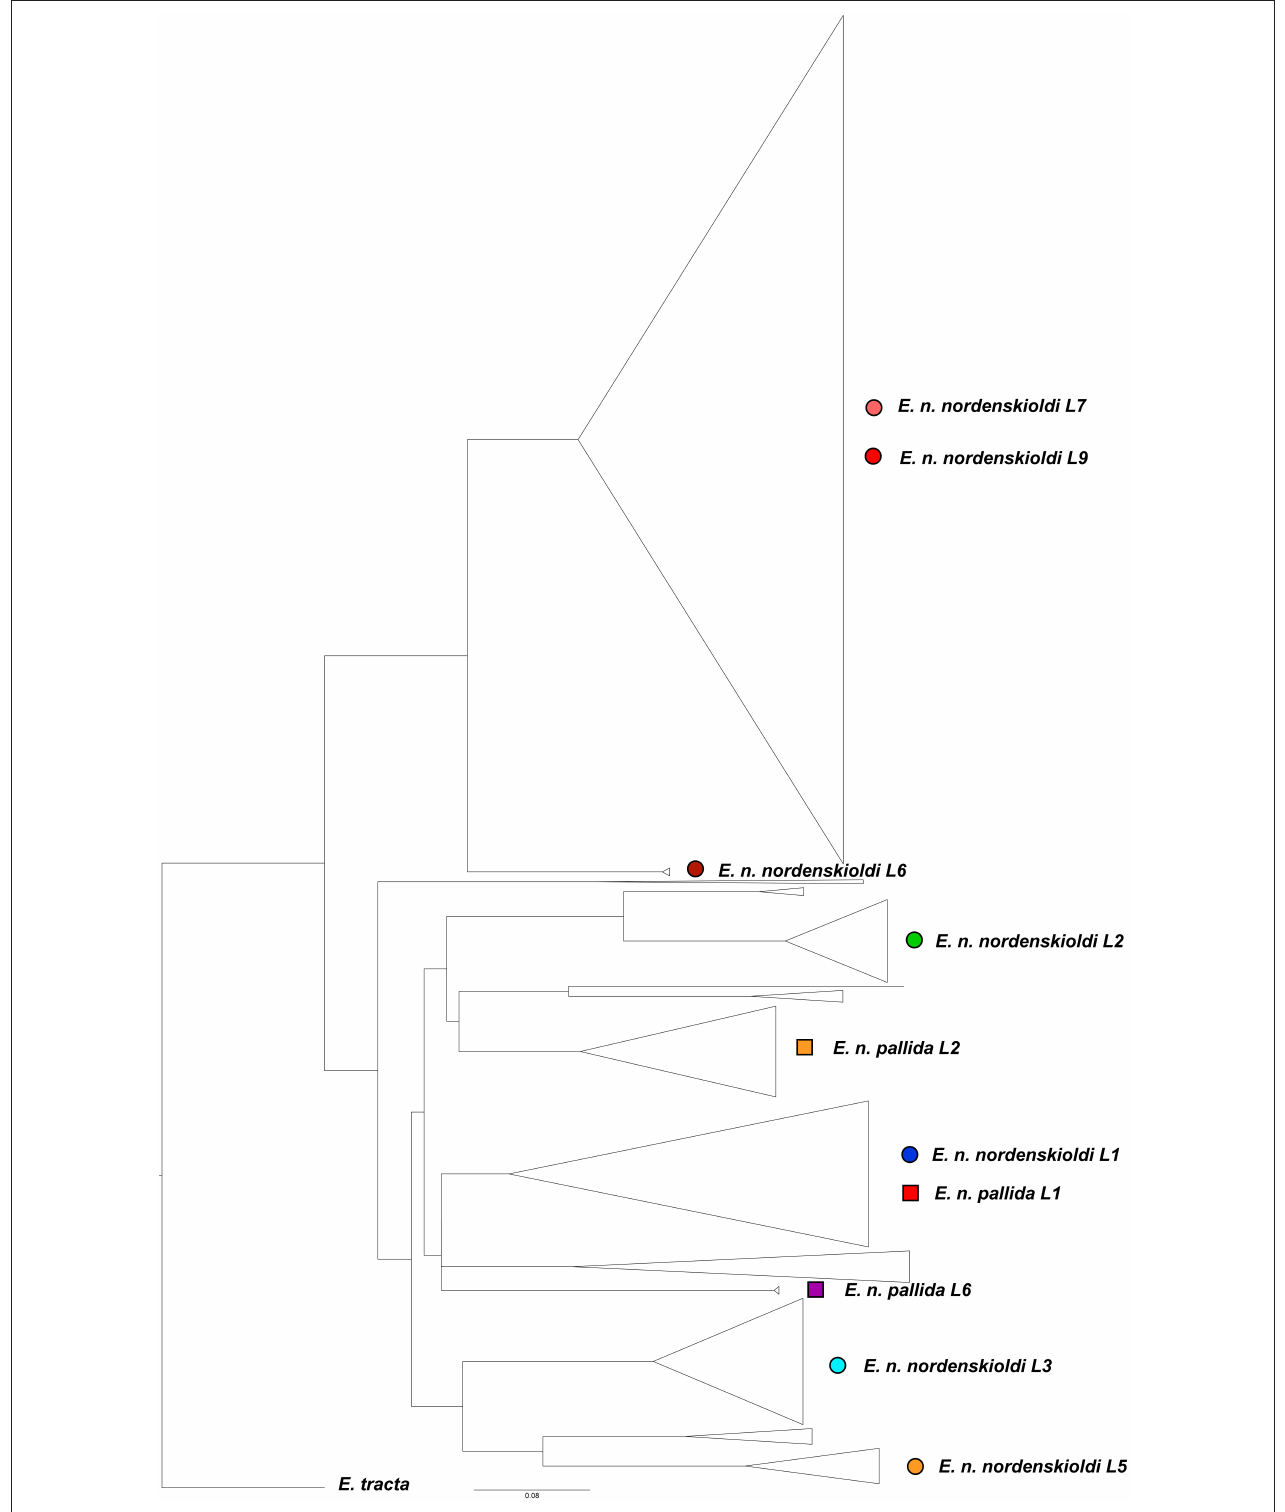
FIGURE 4 | Phylogenetic tree for the COI dataset constructed using the ML algorithm. Lineage symbols refer to Figures 1 – 3 .